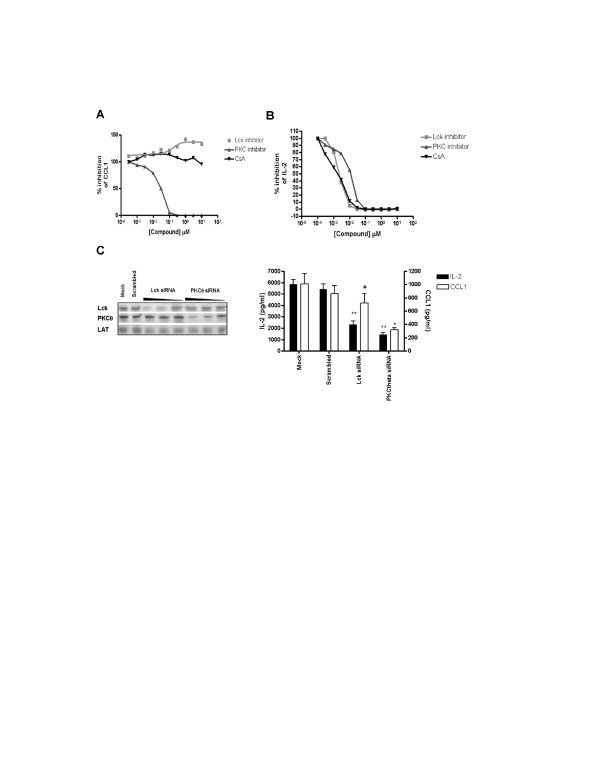
PMA/CD28-induced CCL1 production is not dependent on the Lck/Cn pathway. Jurkat T cells were stimulated using PMA/CD3 and PMA/CD28 in the presence of Lck (A420983), Cn (CsA) and PKC (AEB071) pathway inhibitors for 24 hours. Dose- response effects of the inhibitors were evaluated on the production of CCL1, after PMA/CD28 stimulation (A) and IL-2 after PMA/CD3 stimulation (B) in supernatant of the cell cultures. The data are representative for 3 independent experiments. C; Knock down of Lck and PKCθ resulted in a clear dose-dependent reduction of the protein (500, 100, 20 nM siRNA). 24 hour culture supernatants were collected after stimulation with PMA/CD28 and PMA/CD3 and the effect of knock down on respectively CCL1 and IL-2 was determined. Data of two independent experiments are presented as mean + SEM. Significance of differences are indicated by ** p < 0.01, *p < 0.05, # no difference using a one-way ANOVA with a Bonferroni's post-hoc test. N.b the values shown in this figure are log2 values no to be confused with the intensity values as shown in figure 3.